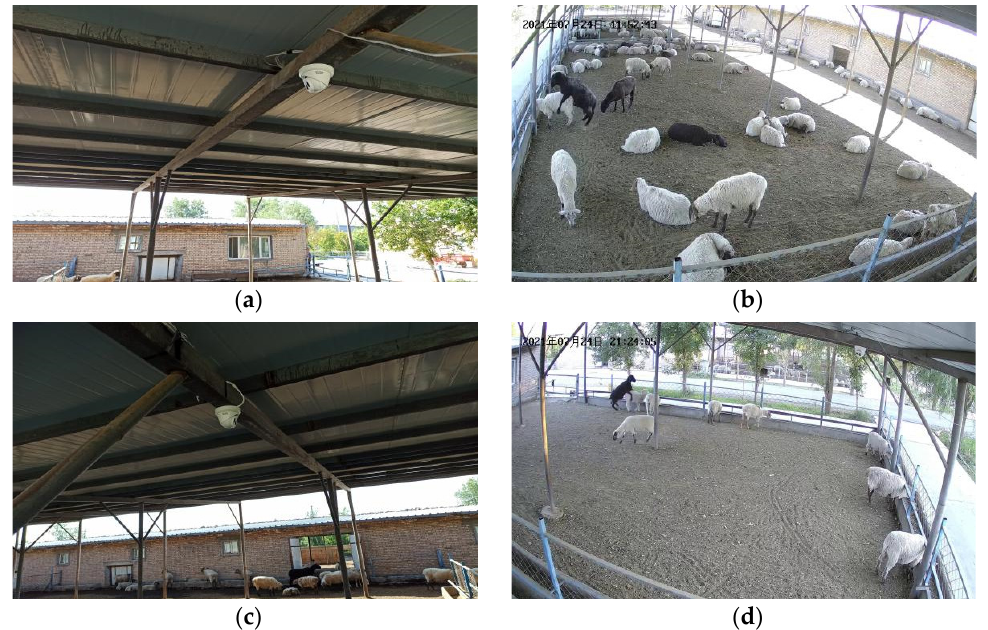
Figure 1. Camera installation position and field of view image: ( a ) Camera 1 installation position; ( b ) Camera 1 view image; ( c ) Camera 2 installation position; ( d ) Camera 2 view image. The Chinese characters in the upper left corner of the image are the date of the video recording, in order of year, month, and day.